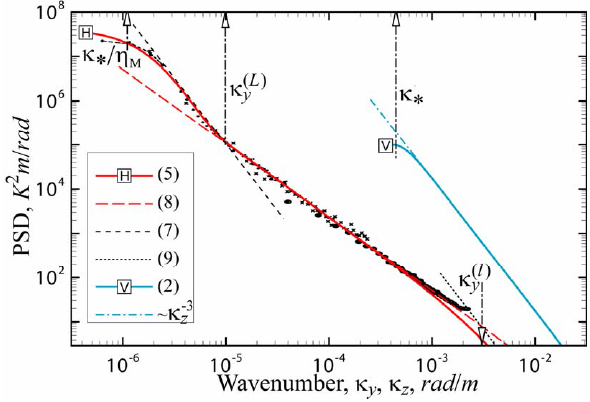
Fig. 1. Comparison of the modeled horizontal (H) and vertical (V) spectra with the measurements [Nastrom and Gage, 1985]. The dots depict the measurements. The equations used to calculate spectral densities (solid curves) and the asymptotic power-law functions (dashed straight lines), are referred to in the legend. Vertical arrows indicate the abscissas for the intersection points of the curves (7) with (8) (labeled by ( ) L y κ ), and (8) with (9) (labeled by ( ) l y κ ).